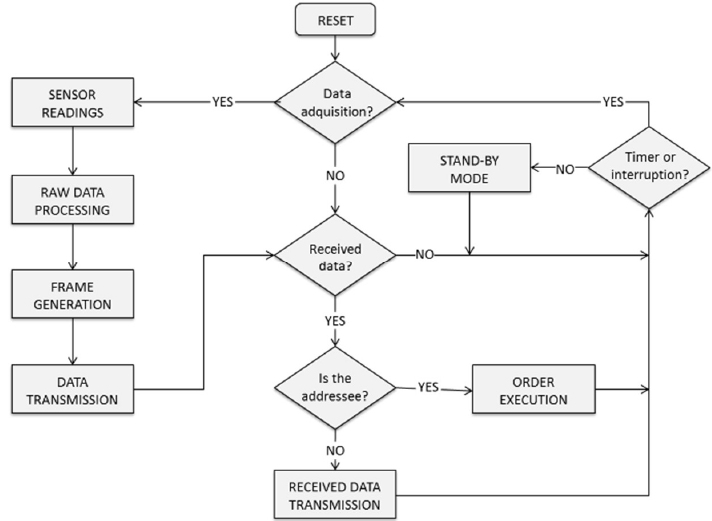
Figure 5. Firmware flowchart.